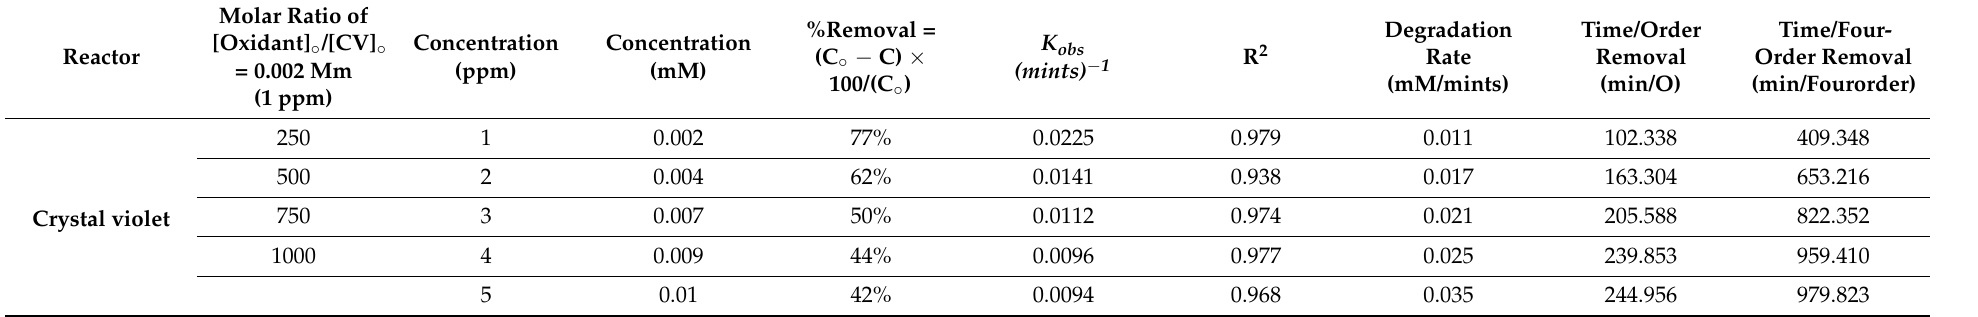
Table 3. Effects of the initial concentration of CV on the removal efficiency, K obs and degradation rate of CV dye by UV only. Experimental conditions: [CV] ◦